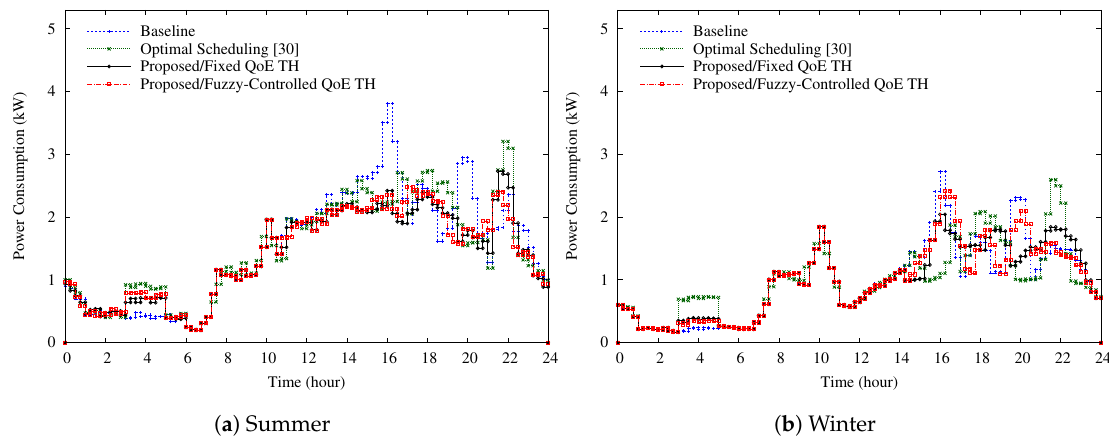
Figure 8. Comparison of power